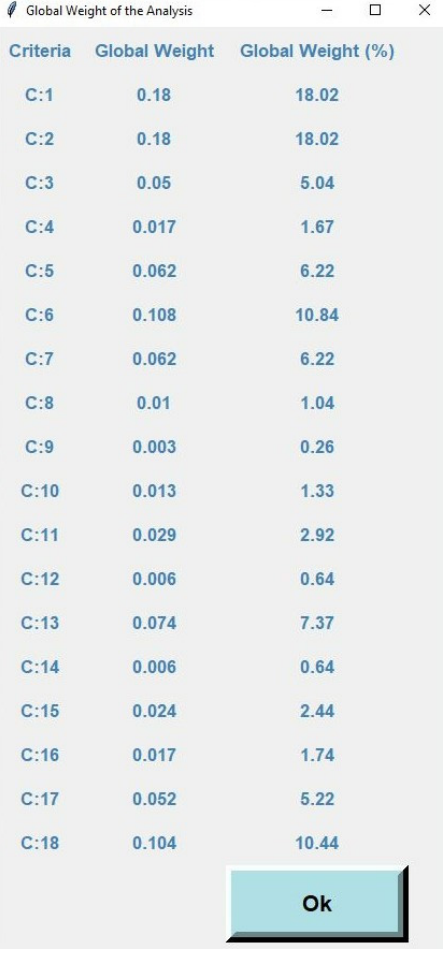
Figure 8. Generation of the global weights for all criteria.